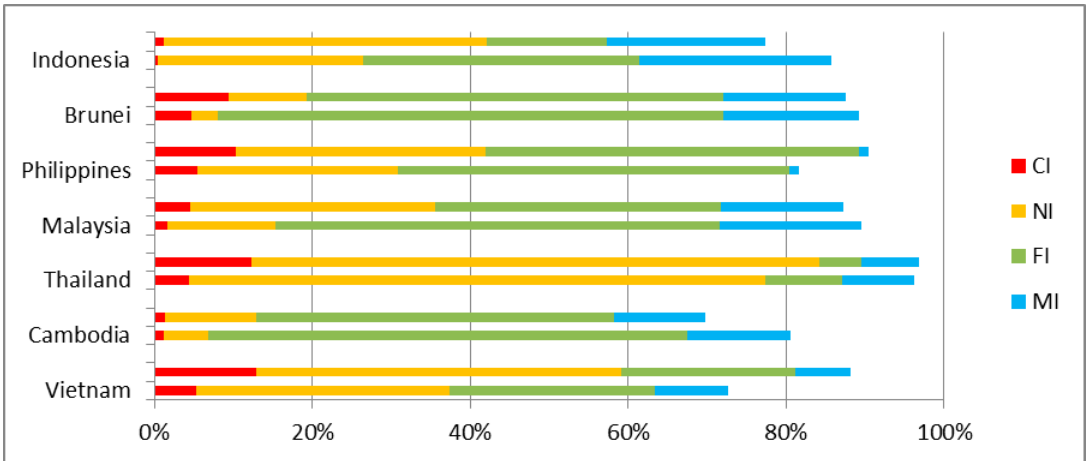
Figure 4. Proportion of the land use types in each country in 1988 and 2018. Note: For each country, the upper column represents the indexes in 2018 while the lower column represents the indexes in 1988.